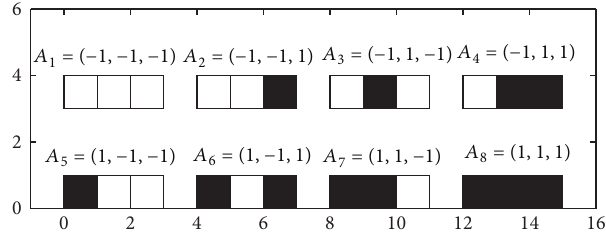
Figure 4: Eight desired memories patterns for Example